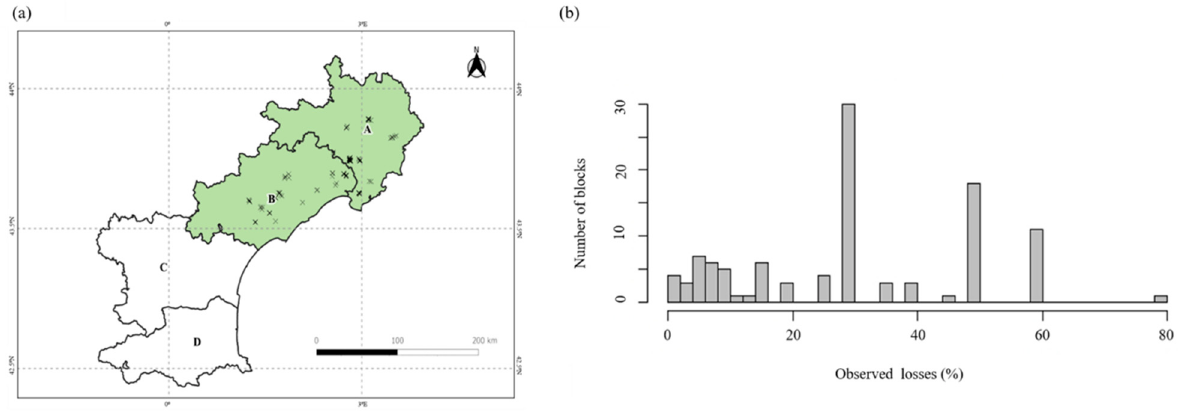
Figure 4. ( a ) Map of the 107 ground truth blocks with a known estimated percentage of yield loss after the heatwave; and ( b ) percentage of yield losses observed by winegrowers and advisors on 107 vine blocks in southern France [18].